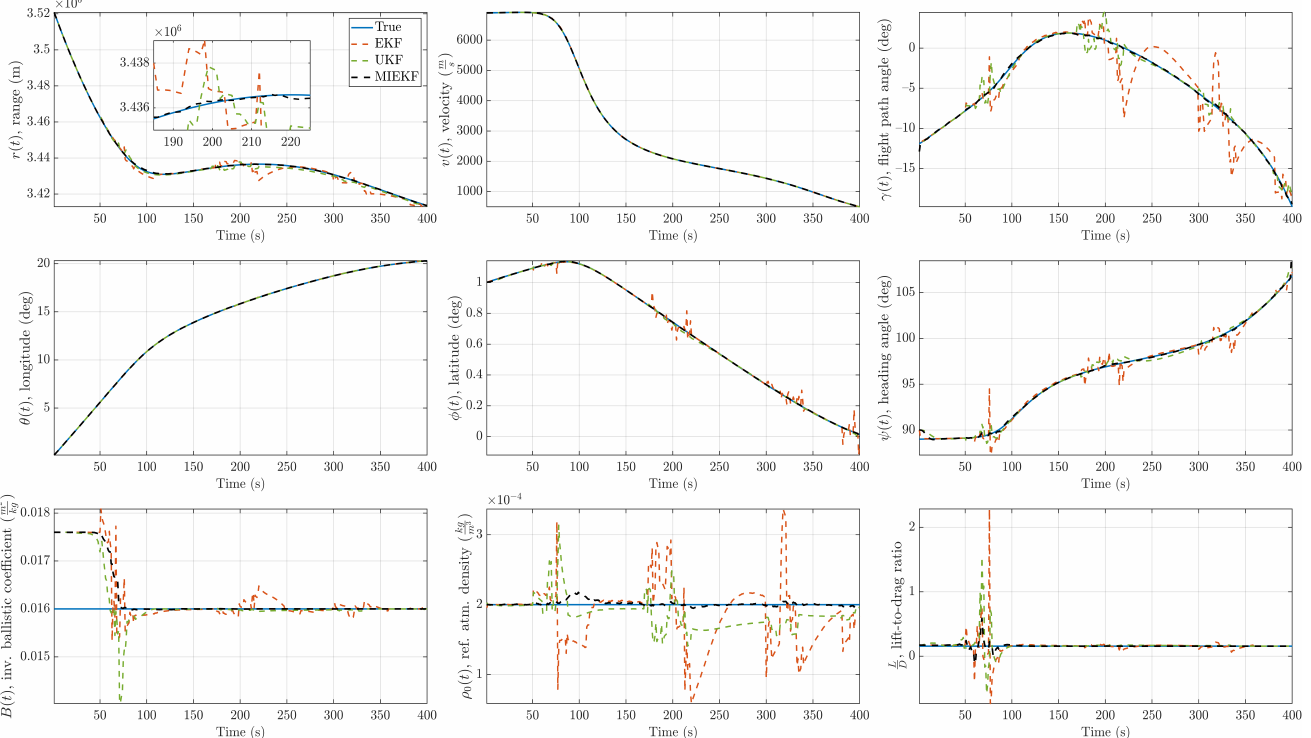
Figure 13. State estimation performance comparison for 40% outlier contamination ( (cid:101) =